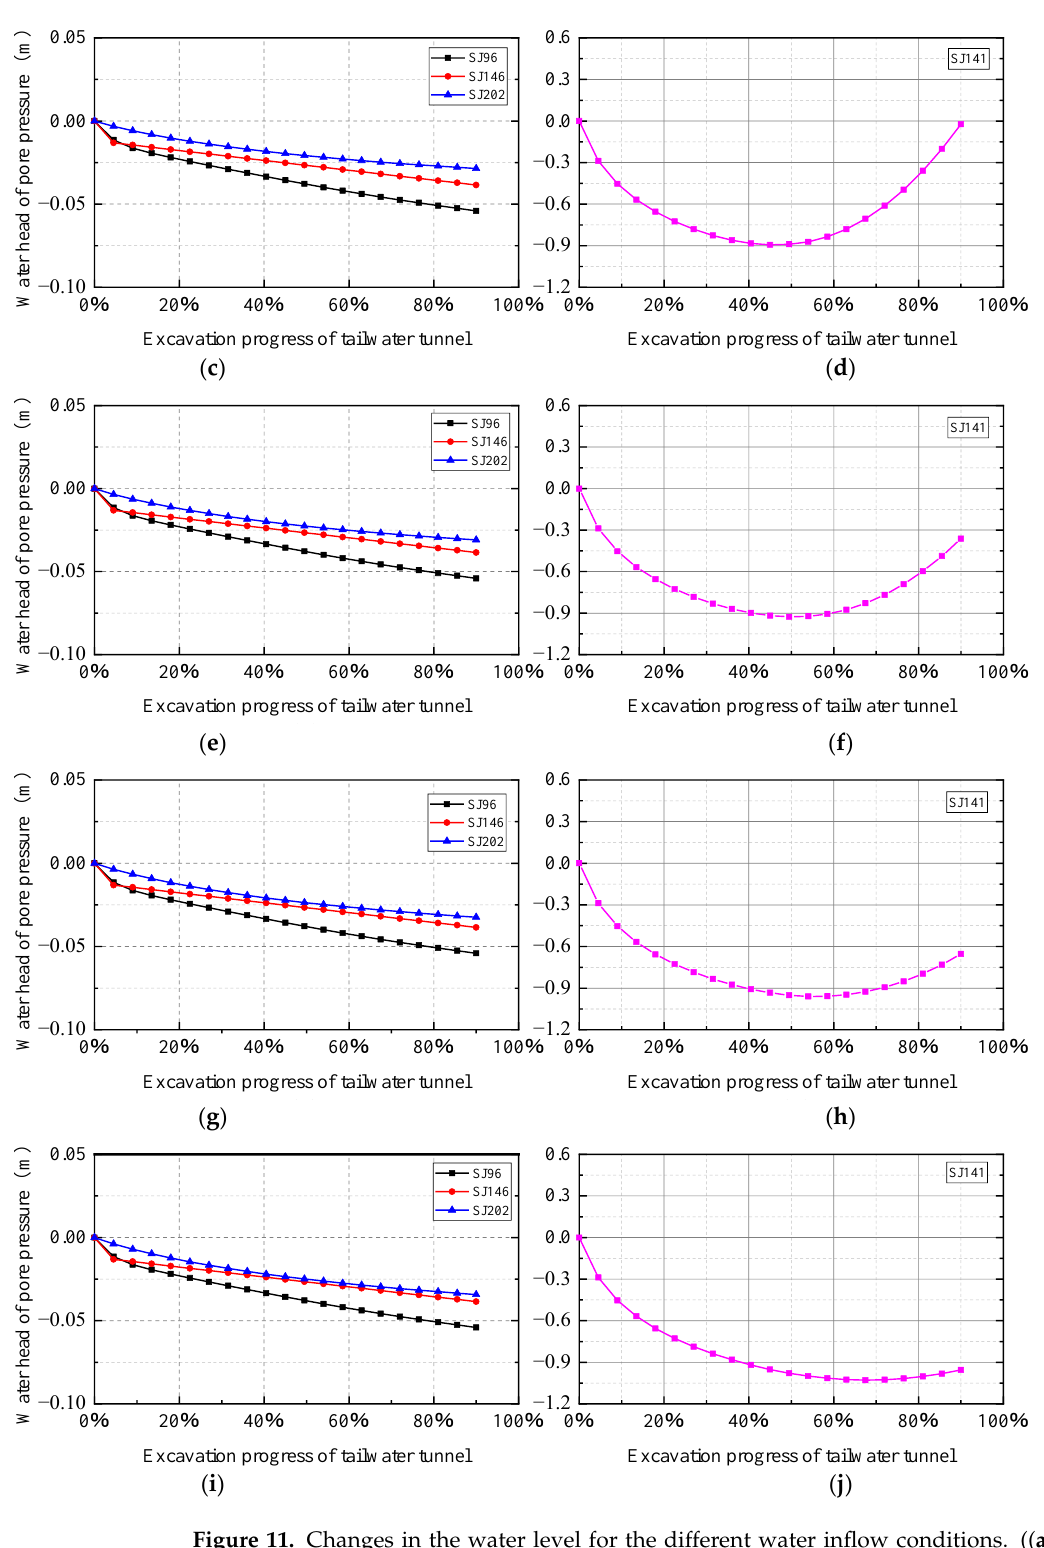
Figure 11. Changes in the water level for the different water inflow conditions. (( a ) and ( b ) are changes in water level of the maximum water inflow of 200 m 3 /d, ( c ) and ( d ) are the variation of water level for the maximum water inflow of 400 m 3 /d, ( e ) and ( f ) are the changes in water level when the maximum inflow is 600 m 3 /d, ( g ) and ( h ) are the changes of water level when the maximum water inflow is 800 m 3 /d, ( i ) and ( j ) are the changes of water level when the maximum water inflow is 1000 m 3